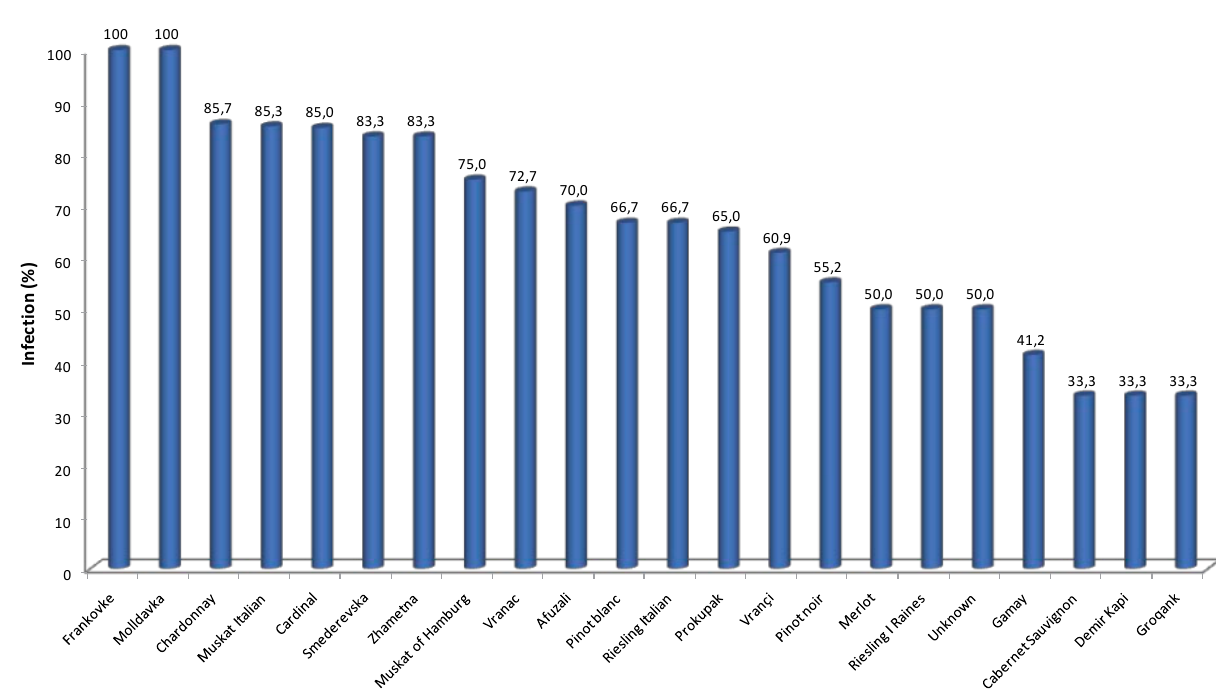
Figure 1. Incidence of viral infections in the main grapevine varieties cultivated in Kosovo, as determined by ELISA tests after analyzing 306 samples.